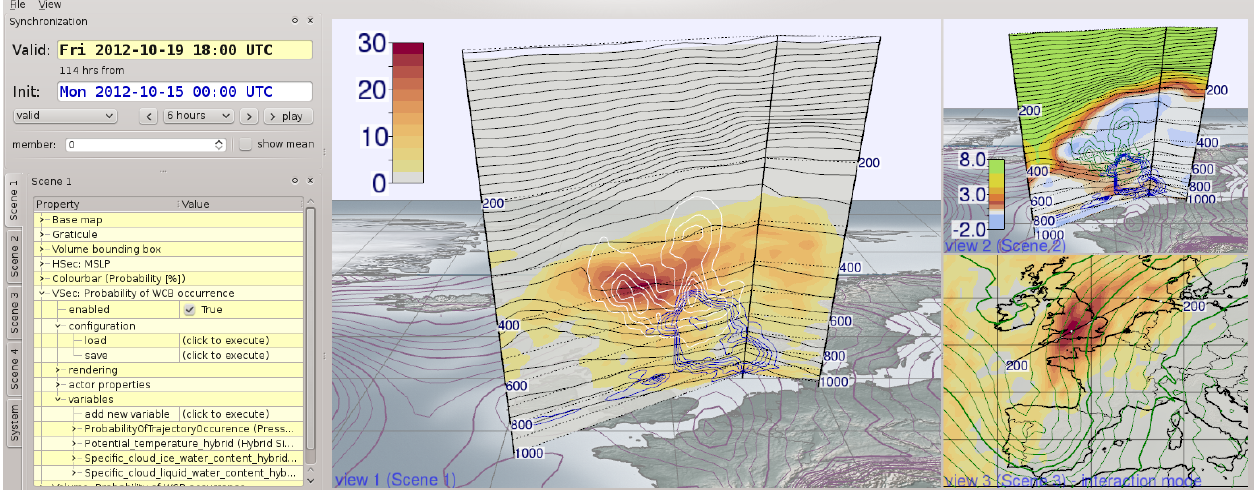
Figure 18. Planning potential flight legs with Met.3D (ensemble forecast from 00:00UTC, 15 October 2012, valid at 18:00UTC, 19 Oc- tober 2012). The large view in the middle shows a vertical section of p( WCB ) (colour scale in %), potential temperature (black contour lines), liquid and ice water content (blue and white contour lines). Purple surface contours show ensemble mean sea level pressure. The small view on the upper right shows a vertical section of potential vorticity (same colour coding and contour lines as in Fig. 17a). The small view on the lower right shows a horizontal section at 390hPa, showing p( WCB ) (same colour scale as in the large view) and contour lines of ensemble mean geopotential height. The maximum p( WCB ) along the proposed leg can be found over southern England at around 400hPa. The vertical section of PV shows how a flight at that altitude, going westward, would penetrate the tropopause shortly after sampling the